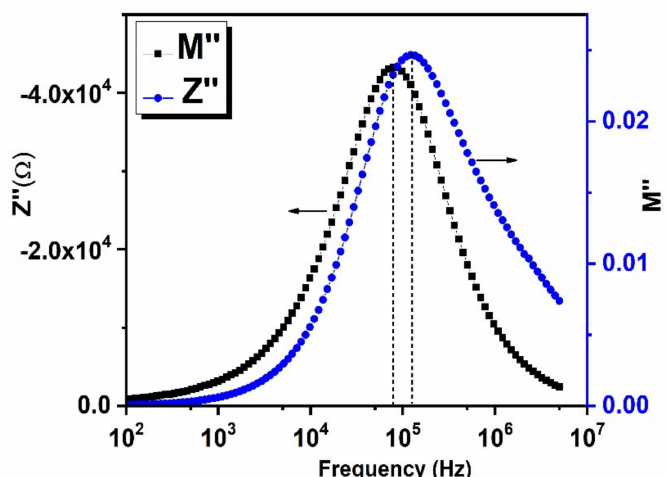
Figure 12. Combined Z (cid:48)(cid:48) and M (cid:48)(cid:48) vs. Frequency plot.